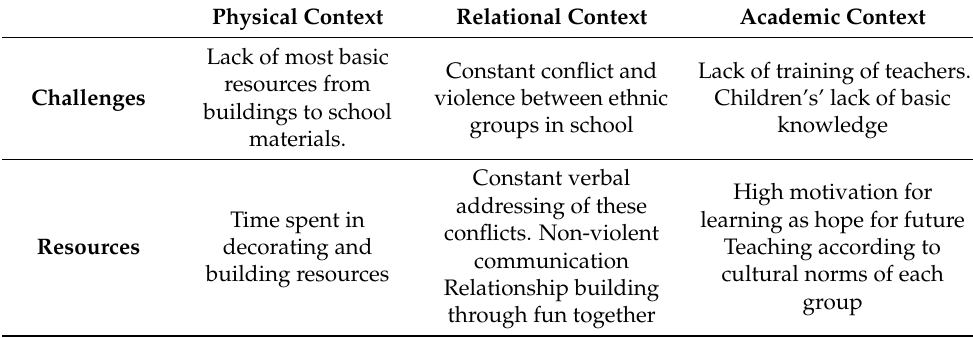
Table 1. The participants three central themes, (physical contexts, relational context, and academic